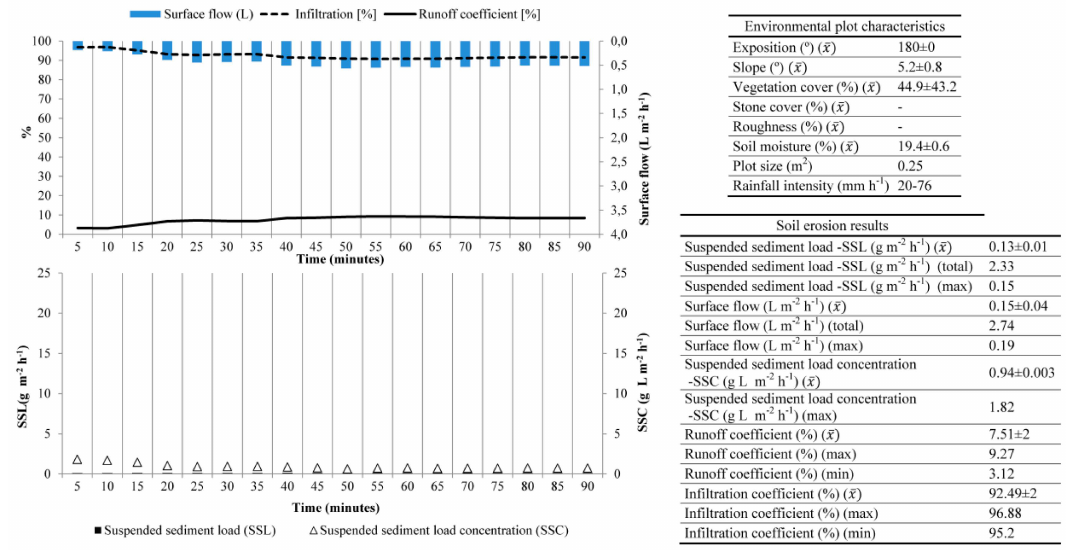
Figure 3. Rainfall simulations in Montagne de Reims (Champagne,